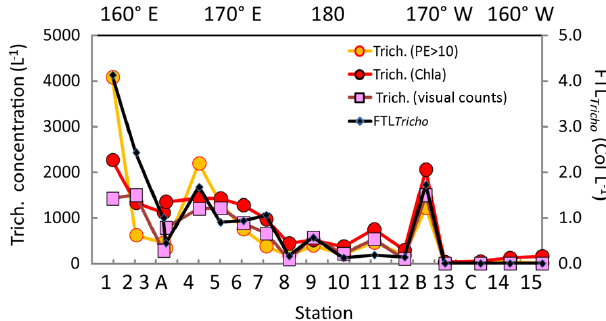
Figure 6. Surface values along the OUTPACE transect of the Tri- chodesmium abundance, in terms of trichomeL − 1 (left axis), de- duced from different methods: (1) visual counts, (2) pigment algo- rithms using TChl a Trich. (Chl a ), or phycoerythrin in the > 10µm fraction Trich. (PE > 10µm). Comparison with FTL Tricho abun- dance (colony counts in coloniesL − 1 by UVP5 at 10m, right axis). The x axis represents the station number (below) or the main longi- tudes (above).